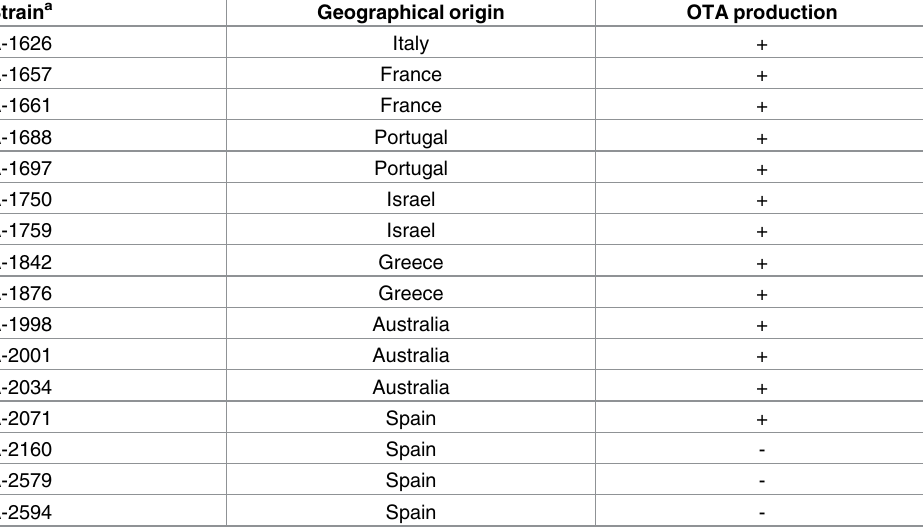
Table 1. List of Aspergillus carbonarius strains from grapes assayedin this study and their properties. Strain a Geographical